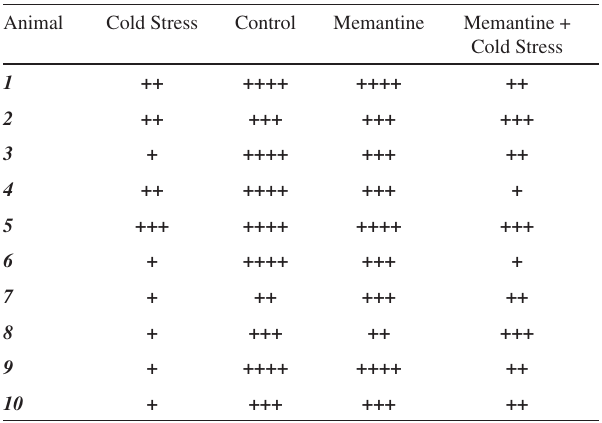
Table 1 - Lipid depletion intensity in adrenal gland cortical cells stained with Sudan IV* (+=small intensity; ++++=high intensity)